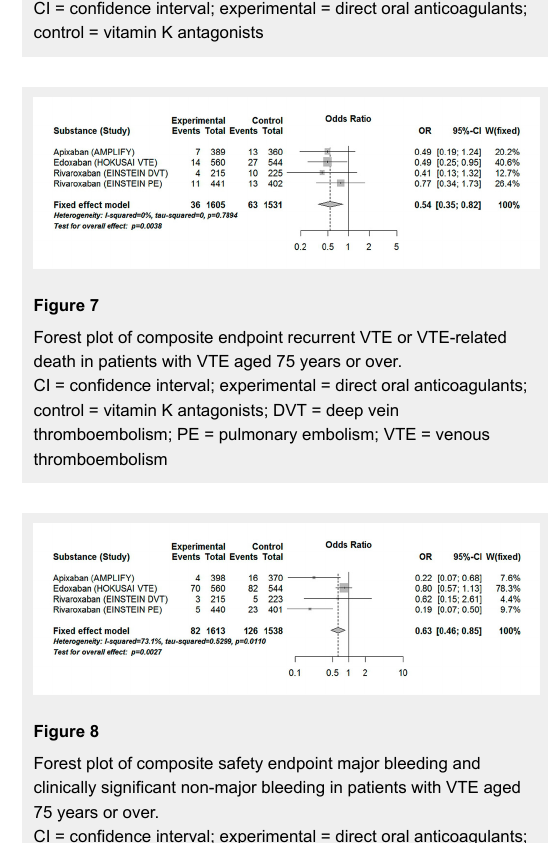
Forest plot of composite major and clinically relevant non-major bleeding in patients with atrial fibrillation aged 75 years or over for analysis including low dose dabigatran and edoxaban. CI = confidence interval; experimental = direct oral anticoagulants; control = vitamin K antagonists